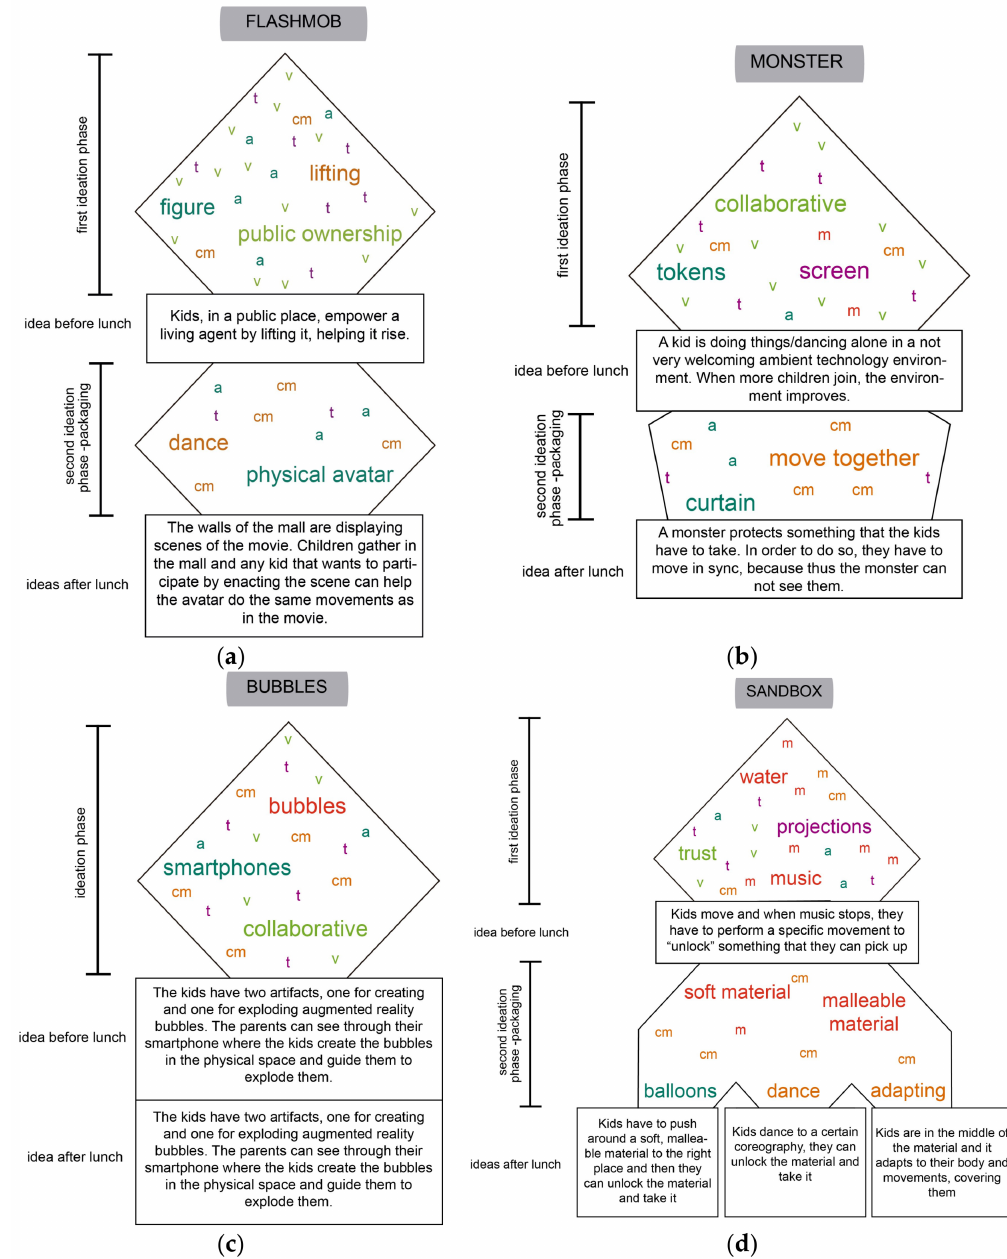
Figure 8. Each panel ( a – d ) depicts a Double Diamond representing one scenario: ( a ) the “flash mob” scenario; ( b ) the “monster” scenario; ( c ) the “bubbles” scenario; and ( d ) the “sandbox”